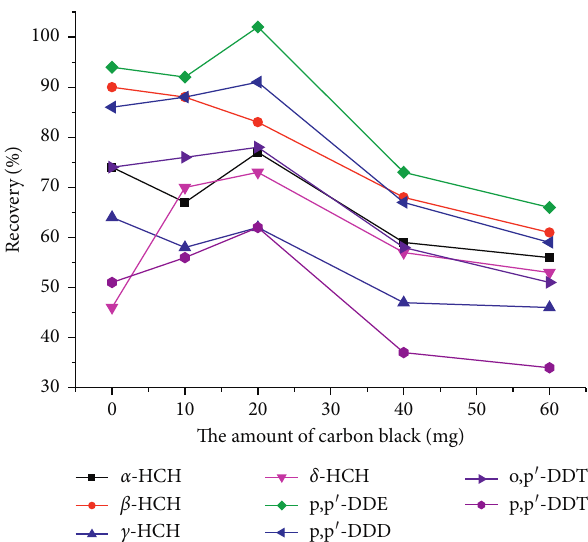
Figure 3: Effect of different amounts of carbon black on recoveries of OCPs.